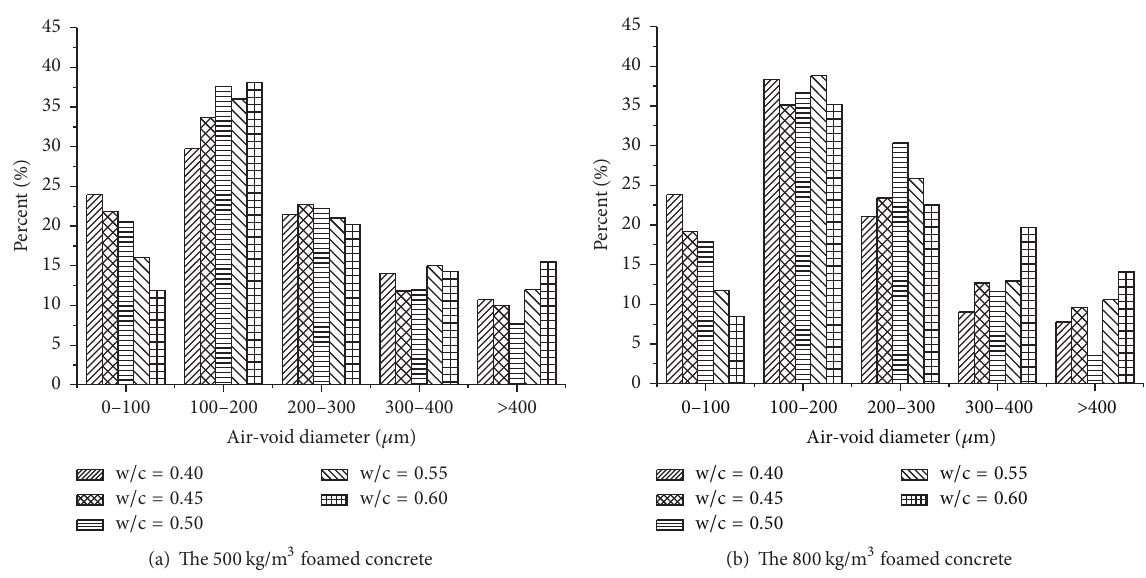
Figure 4: Effects of w/c ratio on the pore diameter distribution.